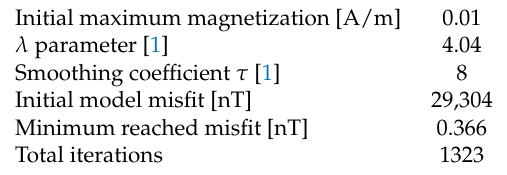
Table 3. Configuration of the magnetic inversion parameters for the T model.